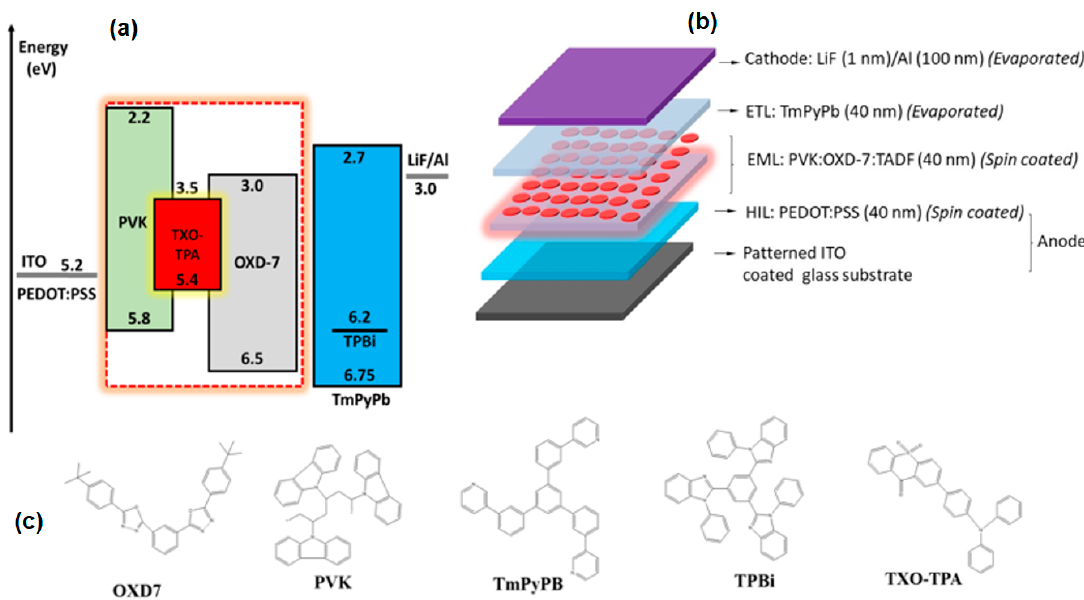
Figure 1. ( a ) The energy diagram and ( b ) the device structure used in this work; ( c ) the molecular structures of 1,3-Bis[2-(4-tert-butylphenyl)-1,3,4-oxadiazo-5-yl]benzene) (OXD-7), poly(N- vinylcarbazole (PVK), 1,3,5-Tri(m-pyridin-3-ylphenyl)benzene TmPyPb, 2,2 ′ ,2 ′′ -(1,3,5-Benzinetriyl)- tris(1-phenyl-1- H -benzimidazole (TPBi), and 2-[4-(diphenylamino)phenyl]-10,10-dioxide-9 H -thioxanthen-9-one (TXO-TPA).